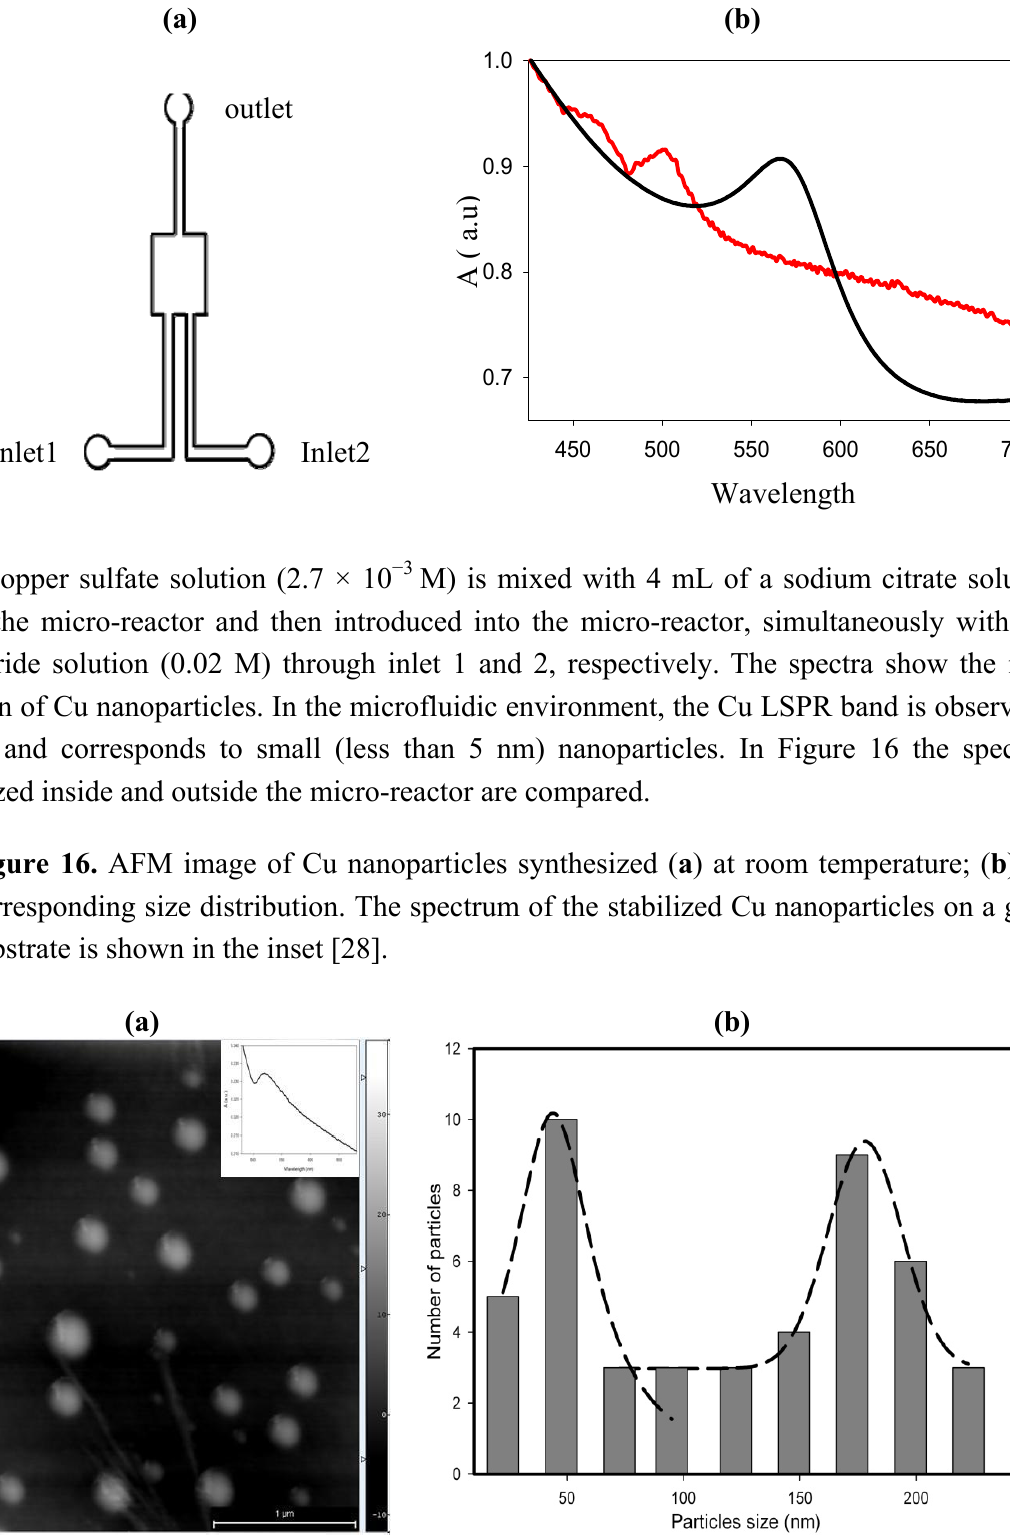
Figure 15. ( a ) PDMS microreactor used for the synthesis of copper nanoparticles; ( b ) Cu LSPR band corresponding to copper nanoparticles synthesized through the “flask method” microfluidic synthesis [27].